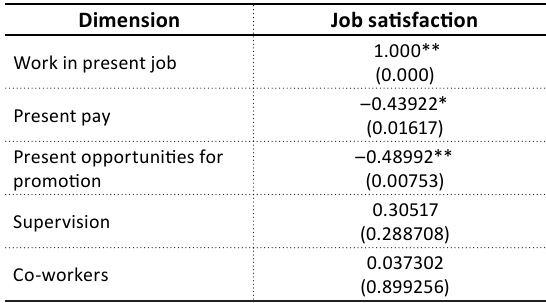
Table 4. The Pearson correlation matrix for dimensions of job satisfaction